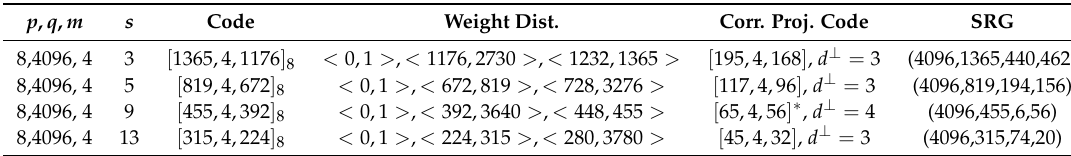
Table 8. Two-weight trace codes over GF ( 8 ) .